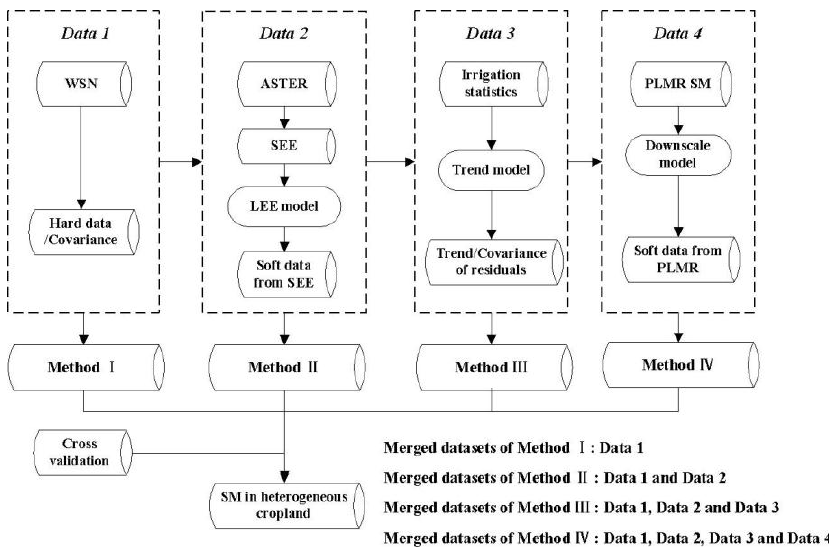
Figure 2. Flowchart of SM estimation in irrigated areas using multi-resource